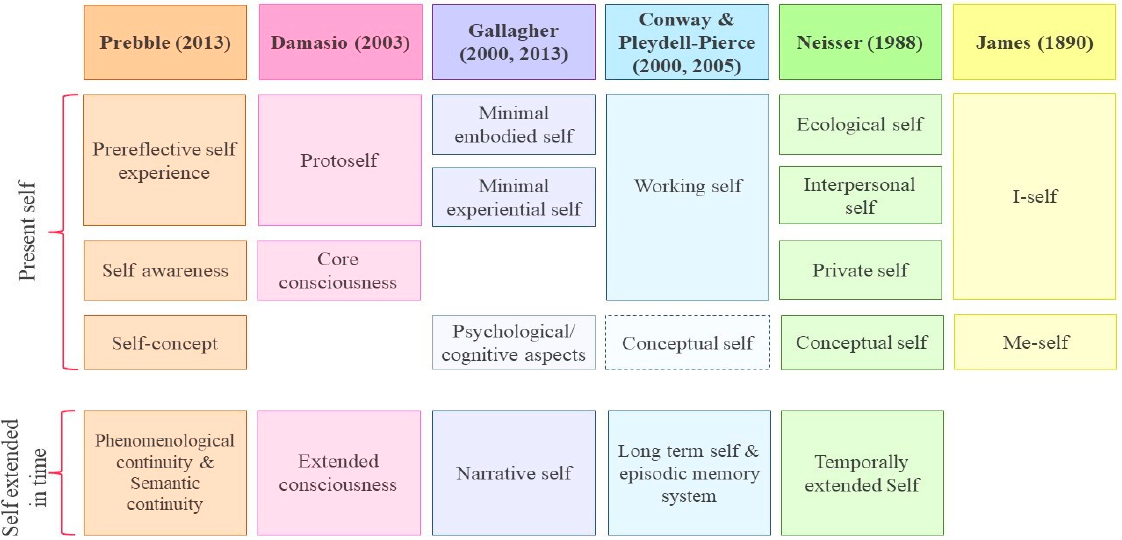
Figure 2. Synthesis of the main models of the self and autobiographical memory, with correspond- ences between the principal components. The orange frames depict Prebble’s model (2013), the pink frames depict Damasio’s model (2003), the purple frames depict Gallagher’s models (2000; 2013), the blue frames depict Conway and Pleydell-Pierce’s models (2000, 2005), the green frames depict Neisser’s model (1988) and the yellow frames depict James’s model (1890).